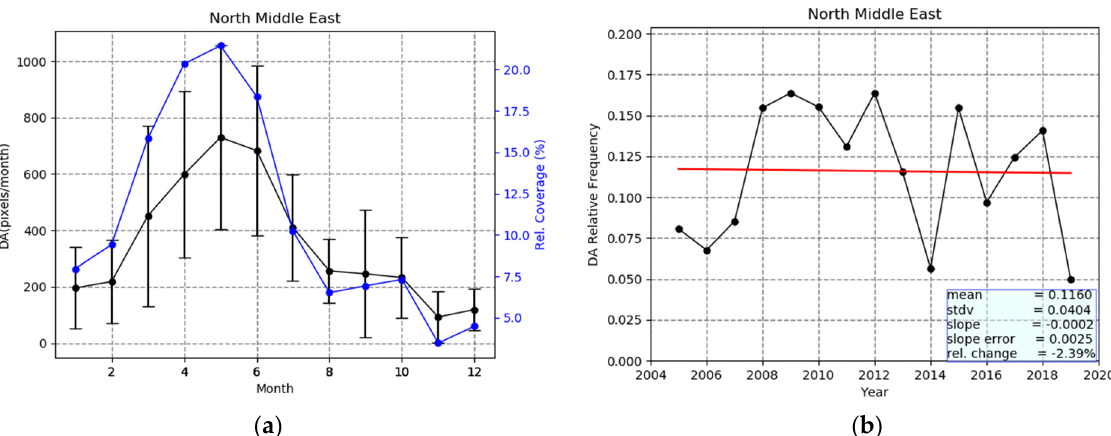
Figure 16. ( a ) Intra-annual variability of the 2005–2019 averages of the total absolute number of grid cells (1 ◦ × 1 ◦ ) where dust aerosols (DA) were detected over North Middle East by the satellite algorithm (left axis) and the percent coverage of the region by dusty grid cells (right axis). The error bars represent the year-by-year variability by means of computed 2005–2019 standard deviations. ( b ) Inter-annual variability and linear trend of the relative frequency of dust aerosols (DA) over North Middle